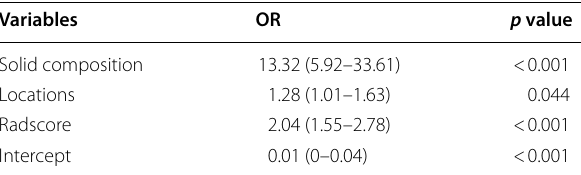
Table 5 Multivariate logistic analysis of clinical and radiomic features and lymph node metastasis